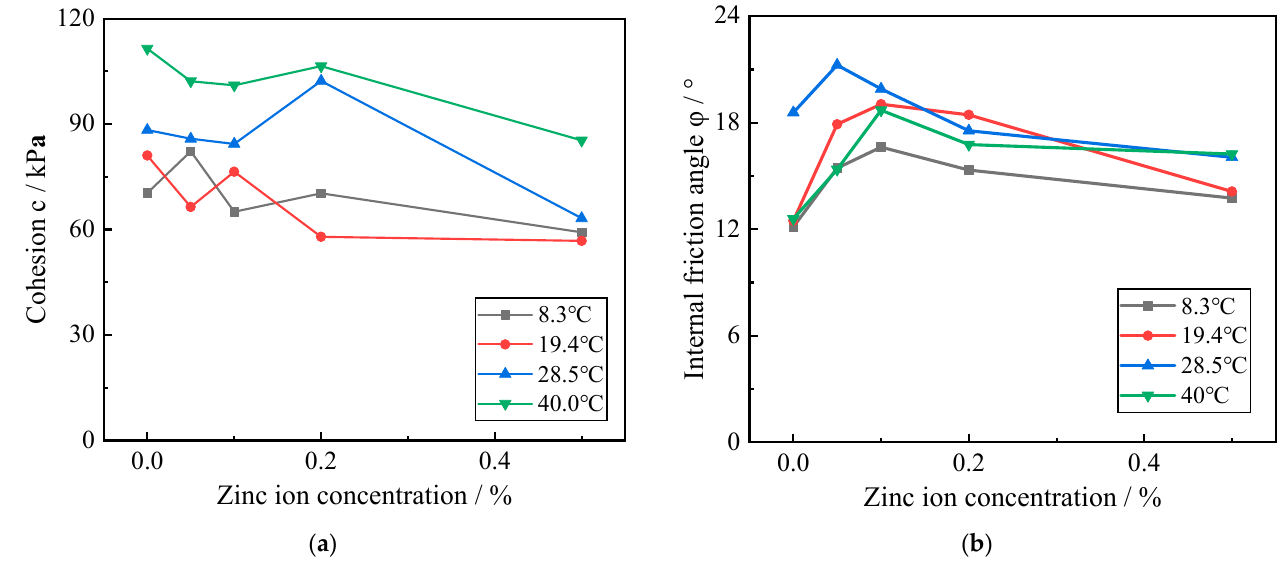
Figure 8. Influence curve of zinc contamination concentration on shear strength index of red clay. ( a ) The variation of cohesion with zinc ion concentration; ( b ) The variation of internal friction angle with zinc ion concentration.